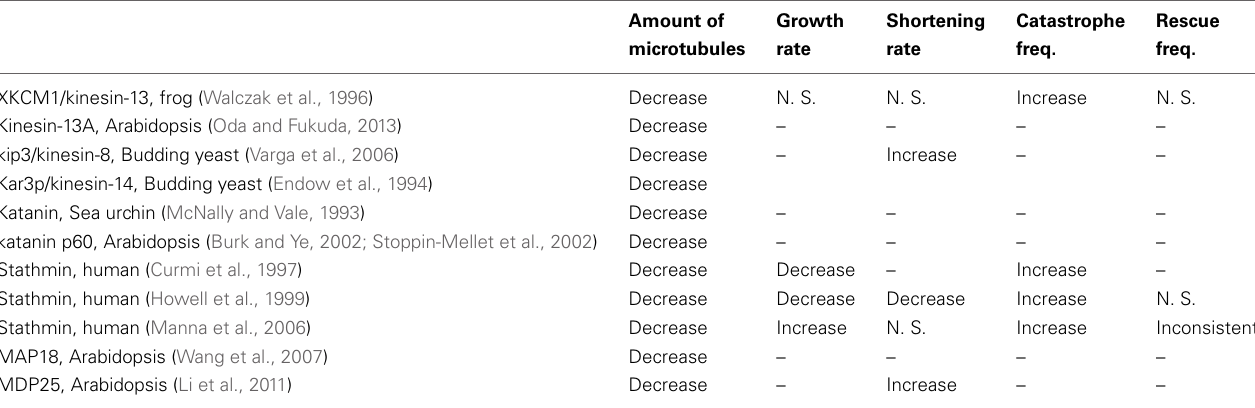
Table 3 | Effects of microtubule destabilizers on microtubule